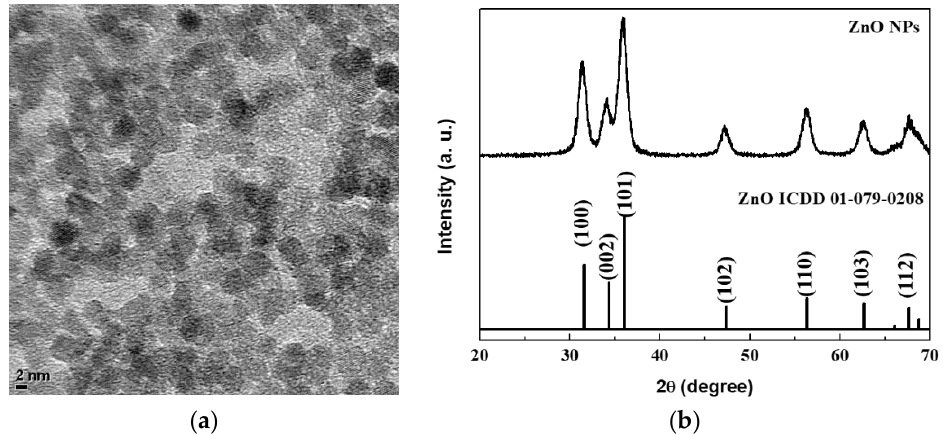
Figure 1. ( a ) transmission electron microscopy (TEM) image and ( b ) X-ray diffraction (XRD) pattern of ZnO nanoparticles (NPs).